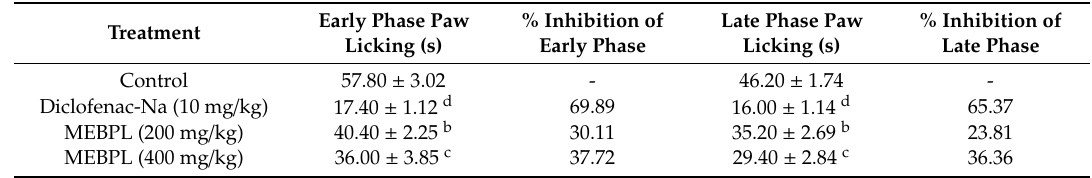
Table 3. E ff ect of analgesic activity of methanol extract of B. pilosa leaves (MEBPL) by formalin induced paw induced test on Swiss albino